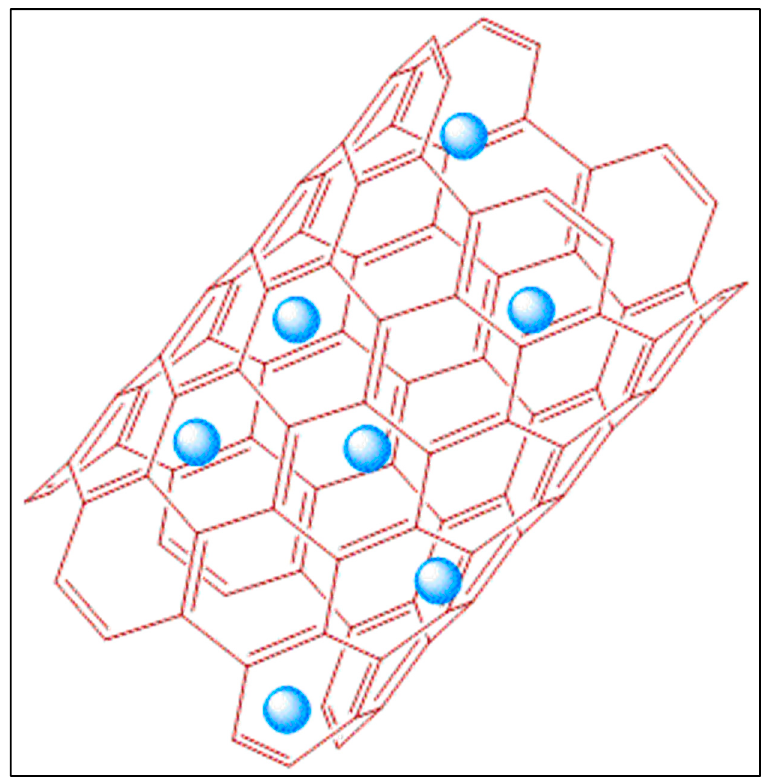
Figure 10. Carbon nanotubes with payload (blue circles).